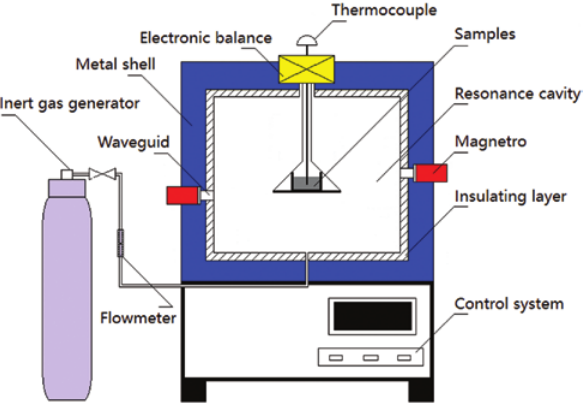
Figure 1: Schematic diagram of microwave heating apparatus.